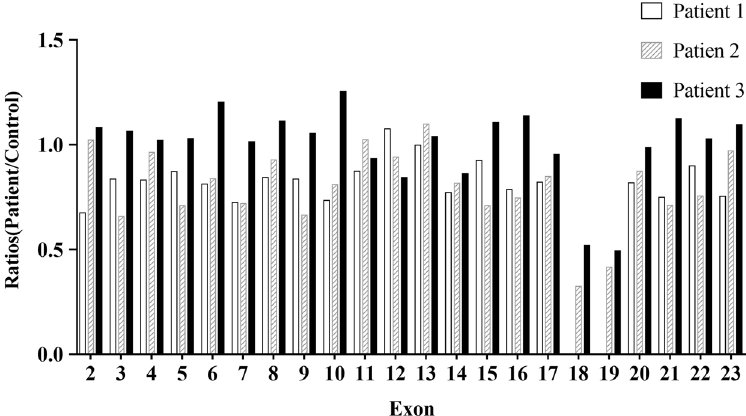
Figure 3. Patient/control ratios of the number each exon sequence reads. The patient/control ratios of all three patients were compared from exons 2 through 23 of POMGNT1 , and performed near the level 1.0 on the vertical axis except the region of exons 18 and 19. The ratios of patient 1 were 0 in the region of exons 18 and 19, suggesting homozygous deletion of exons 18 and 19. The ratios of patient 2 and patient 3 were near 0.5 in the region of exons 18 and 19, suggesting heterozygous deletion of exons 18 and